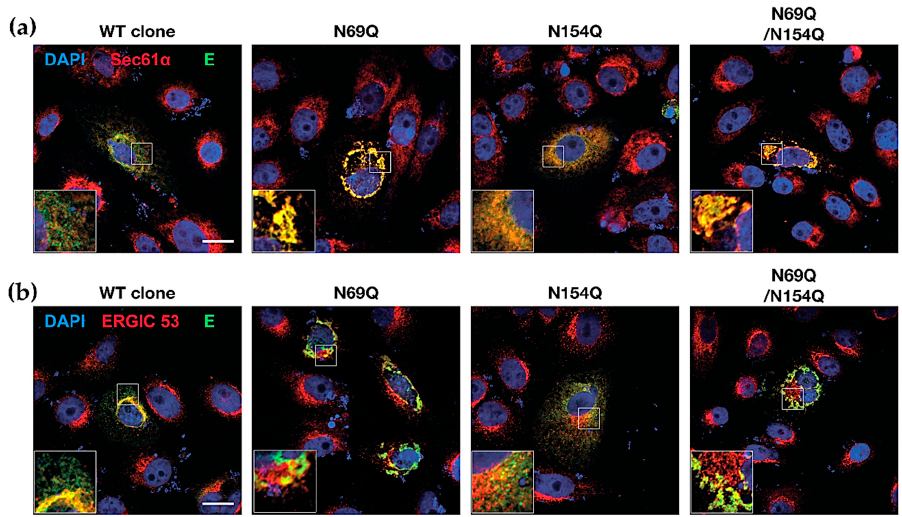
Figure 5. Co-localization of the E protein expression with various cellular protein markers. Vero cells were transfected with pcDNA3.1-prME plasmids. ( a ) The immunofluorescence microscopy images of ZIKV E-Sec61 α double-stained Vero B4 cells. After 48 h, cells were stained with a rabbit anti-ZIKV E protein antibody and a mouse anti-Sec61 alpha antibody followed by secondary antibody and DAPI. ( b ) The immunofluorescence microscopy images of ZIKV E-ERGIC (ER-Golgi intermediate compartment) 53 double-stained Vero B4 cells. After 48 h, cells were stained with a rabbit anti-ZIKV E protein antibody and a mouse anti-ERGIC 53 antibody, followed by secondary antibody and DAPI. The samples were analyzed using a Zeiss 710 confocal microscope and ImageJ software. Scale bar = 20 µm. Sec61 α = Protein transport protein Sec61 subunit alpha; ERGIC 53 = ER-Golgi intermediate compartment 53 kDa protein or lectin mannose-binding 1.